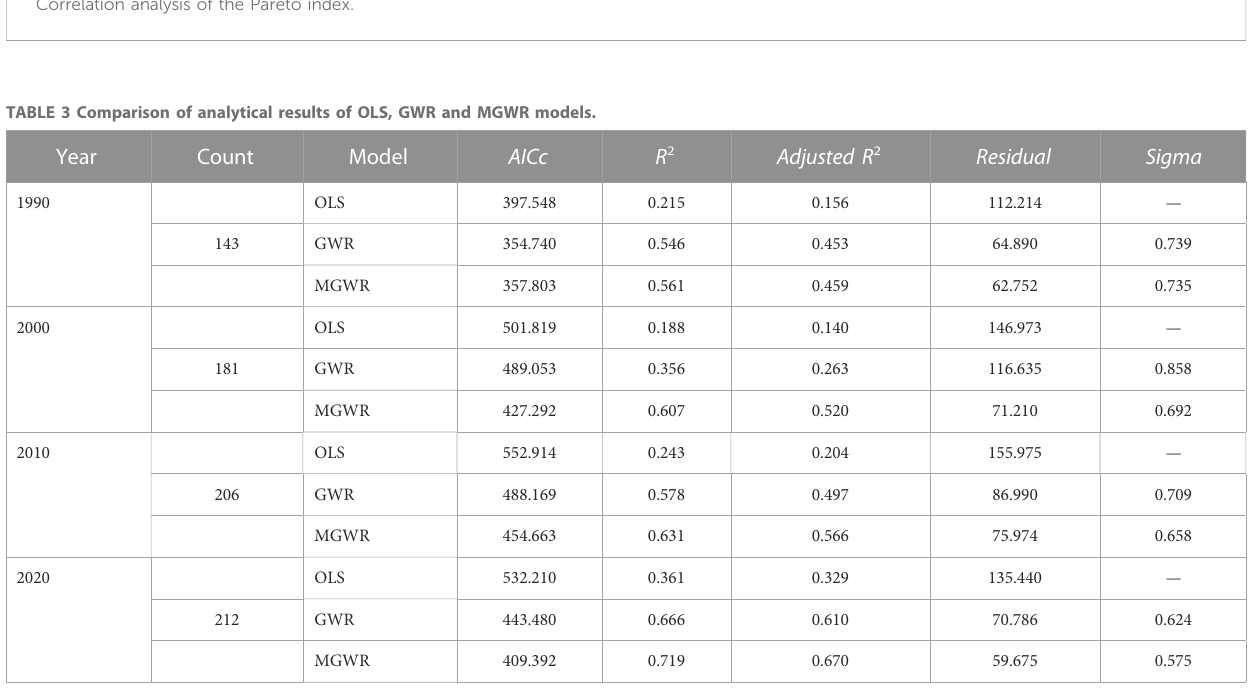
FIGURE 9 Correlation analysis of the Pareto index.